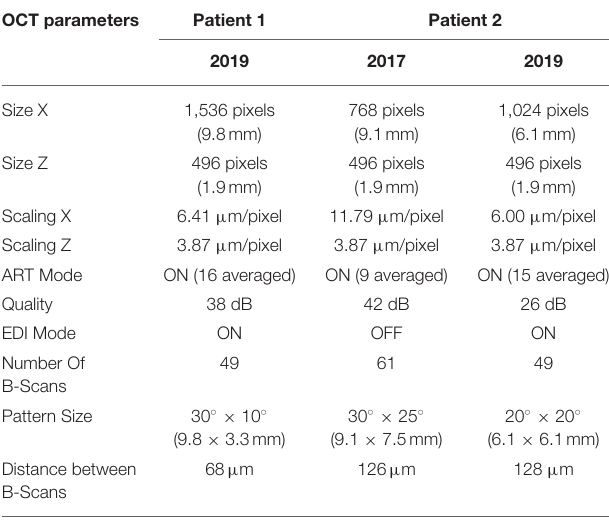
TABLE 1 | Optical coherence tomography imaging